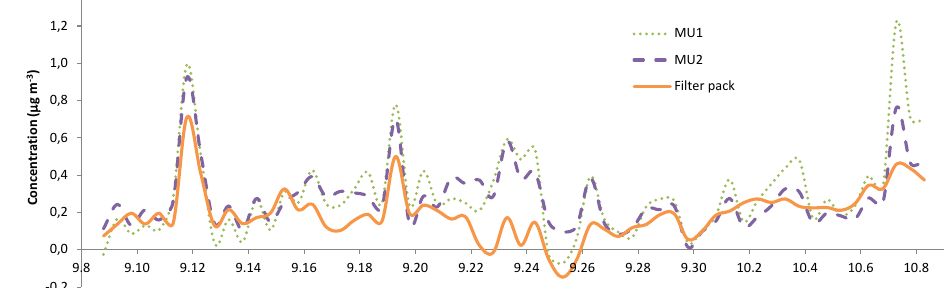
− (total NO − minus NaNO 3 ) for the MUs and filter pack during the ETV 3 3